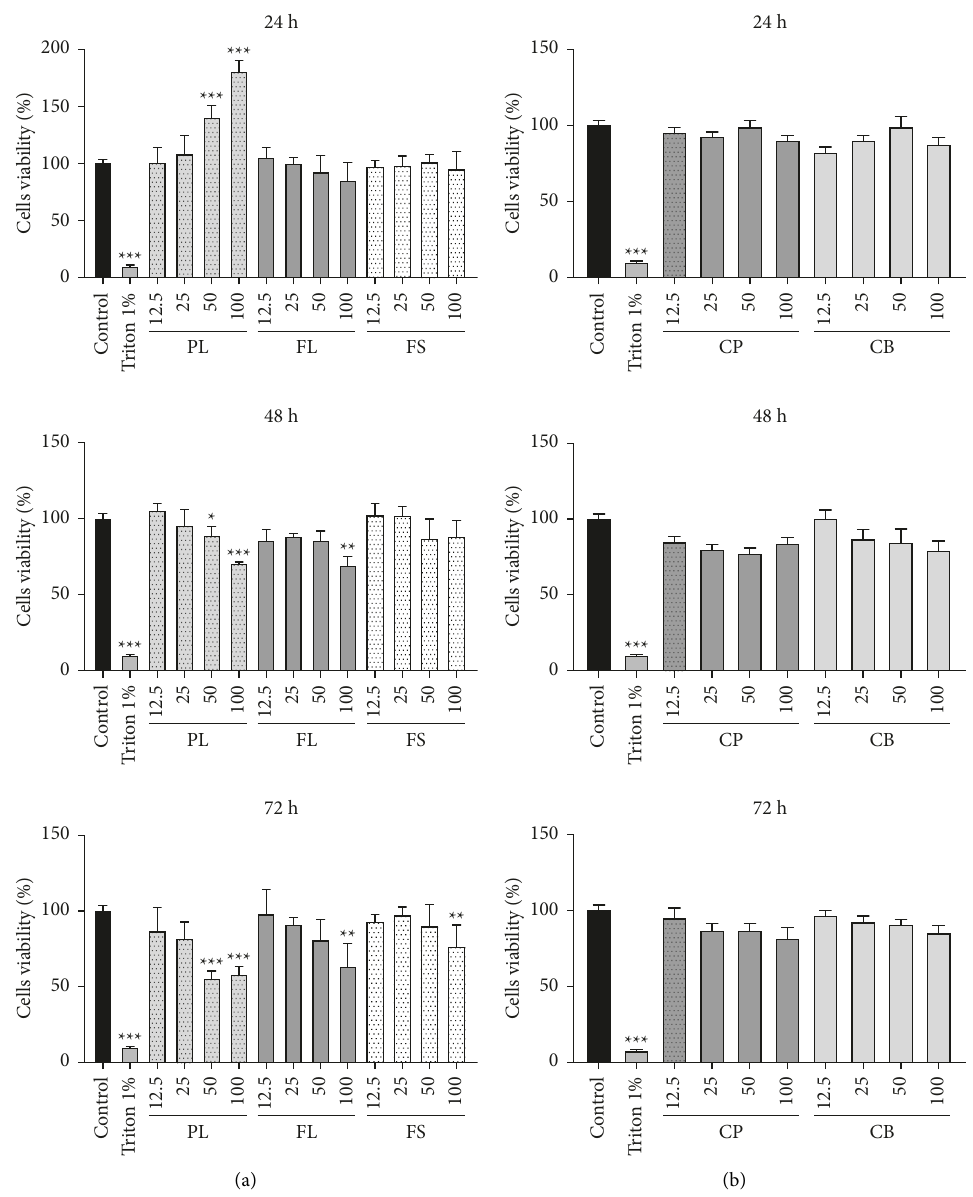
Figure 6: Effect of hydroethanol extracts (PL, FL, and FS) and various collagens (CP and CB) on the viability of keratinocytes (HacaT) after 24h, 48h, and 72h incubation. PL: P. lentiscus leaf extract; FL: C. officinalis leaf extract; FS: C. officinalis flower extract; CP: fish collagen; CB: bovine collagen. HaCaT cells are treated with the different concentrations of collagens and ethanolic extracts (12.5 and 25 μ g/mL) for 72 hours of incubation, and the cell viability is assessed by the MTT assay. The values presented are means representative of three independent